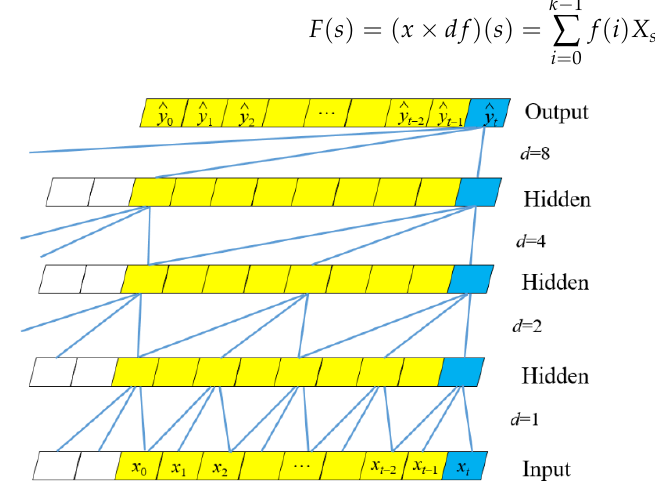
Figure 1. Schematic diagram of TCN model structure.